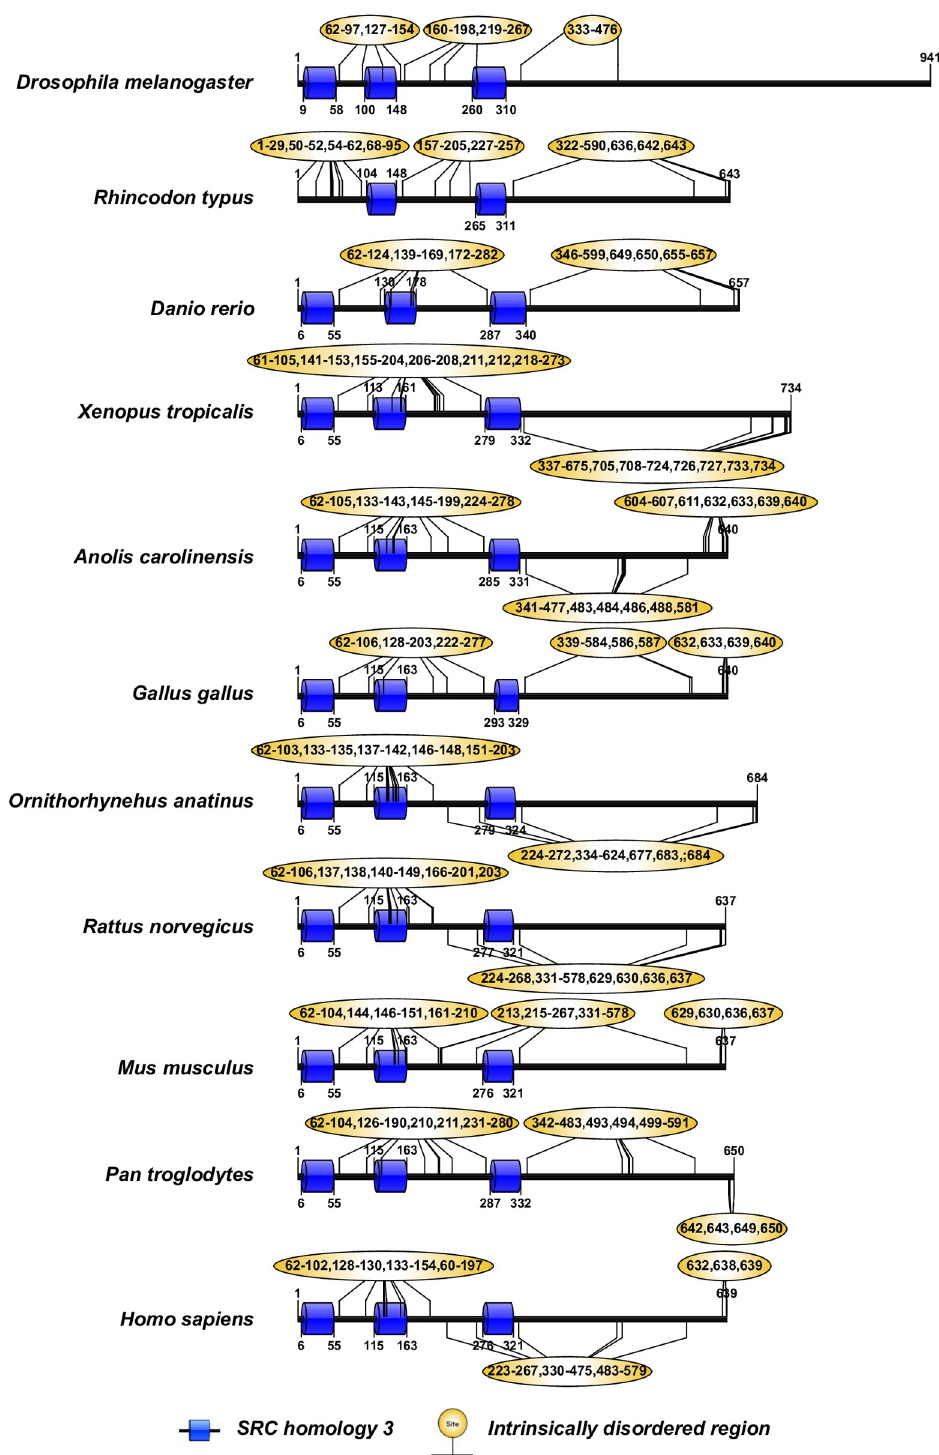
Fig 4. Domain organization in CD2AP and CINDR sequences. Note: Yellow bubbles represent the intrinsically disordered regions.